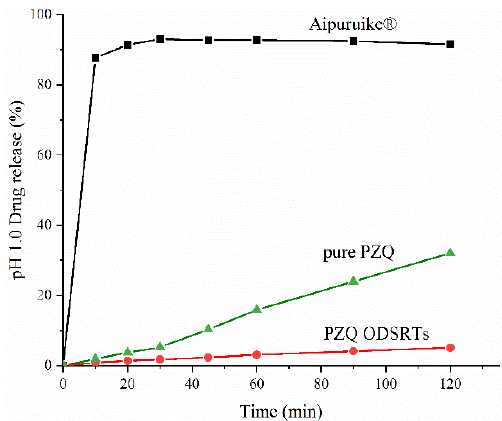
Figure 4. FTIR spectra of pure PZQ, a physical mixture, extrudate and HPMCAS.